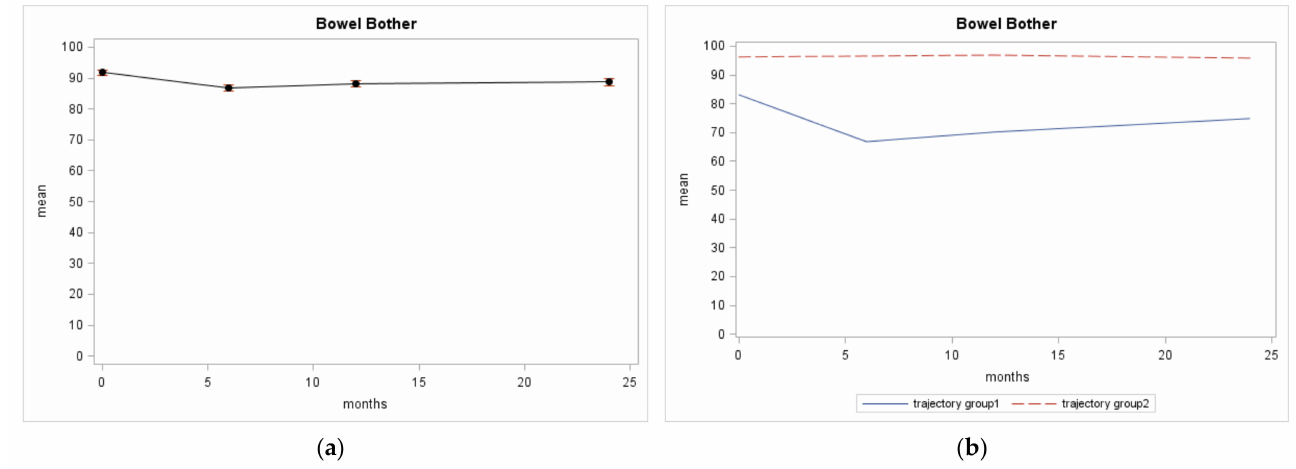
Figure 3. Italian-UCLA-PCI BB scores from Pros-IT participants across 4 evaluations; ( a ) Overall mean and standard error; ( b ) BB trajectory patterns identified.